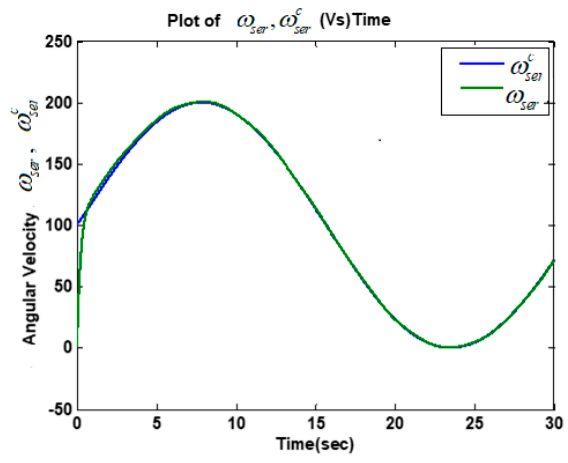
Figure 5. Plots of the servomotor speed command profile ω c ser ( t ) ( rad / s ) and speed ω ser ( t ) ( rad / s )